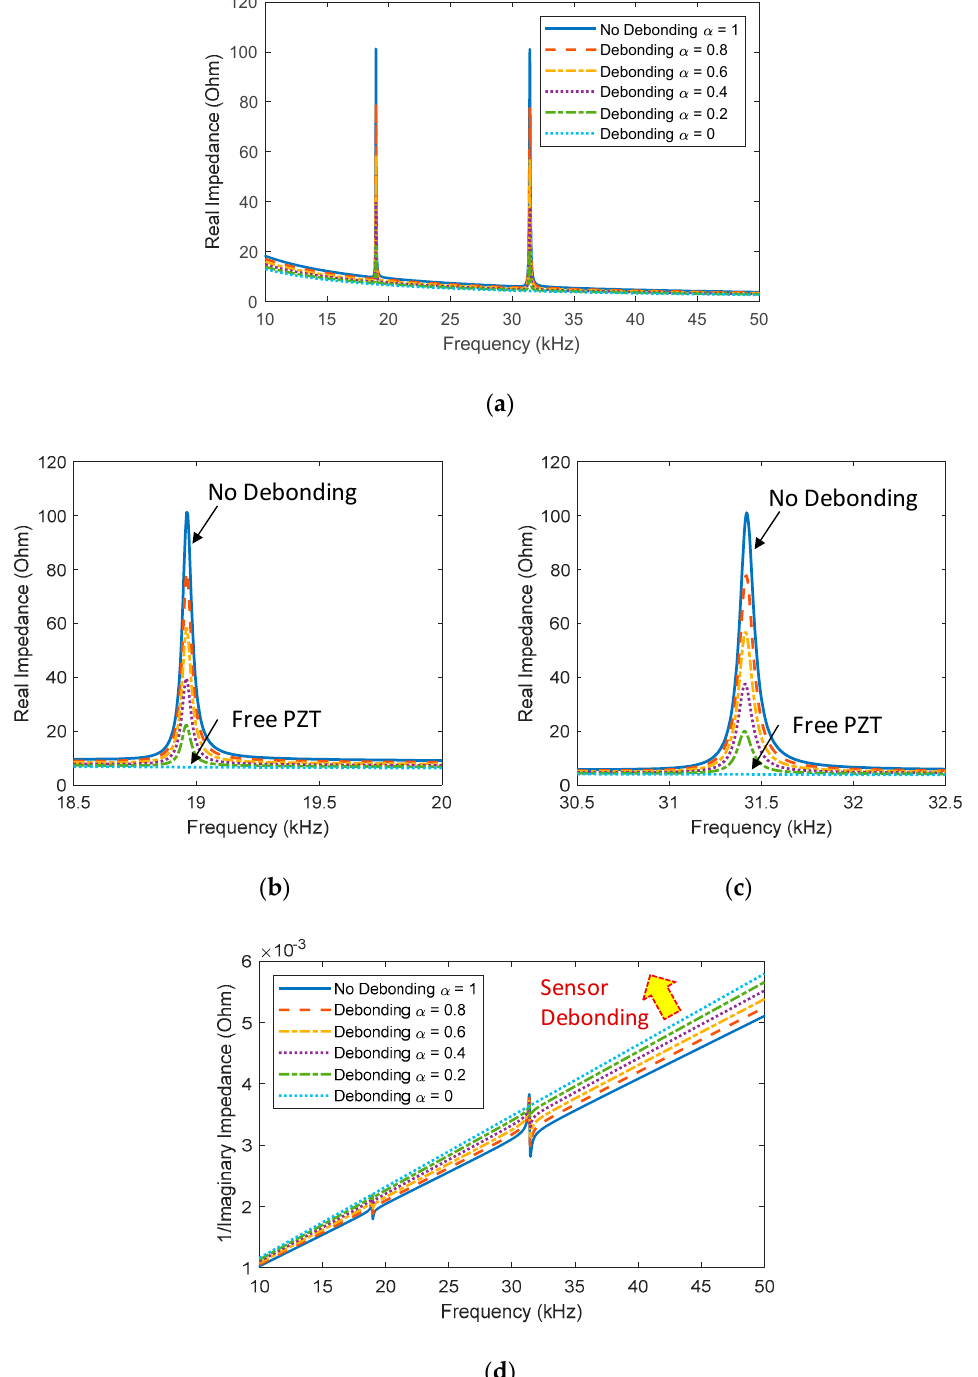
Figure 11. Analytical impedance signatures under the sensor debonding effect: ( a ) real part in 10–50 kHz; ( b ) real part in 18.5–20 kHz; ( c ) real part in 30.5–32.5 kHz; ( d ) imaginary part in 10–50 kHz.